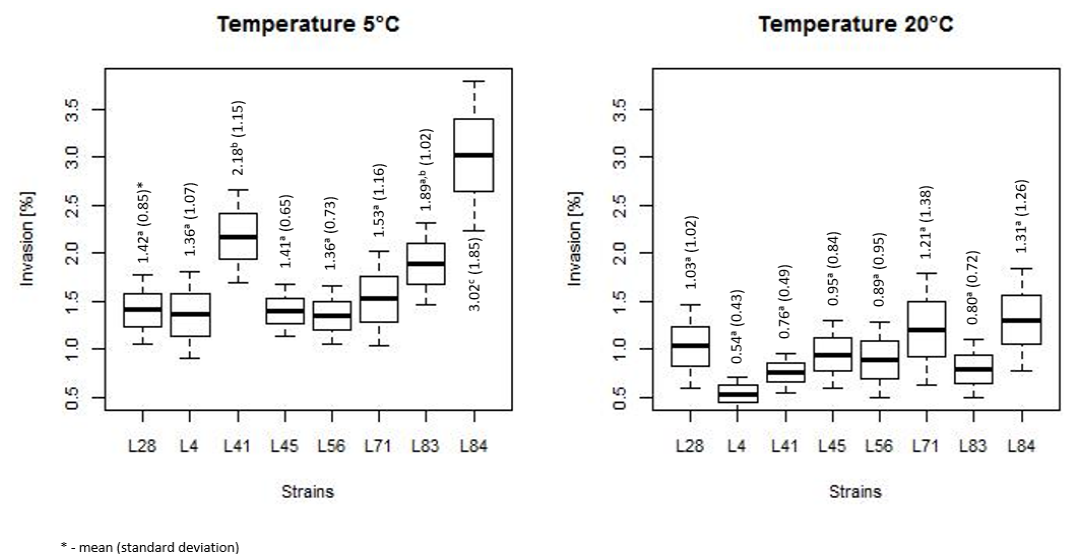
Figure 5. The summarized invasiveness for various strains (the horizontal line is the mean, the box spans represent standard error and the whiskers represent 95% confidence interval).